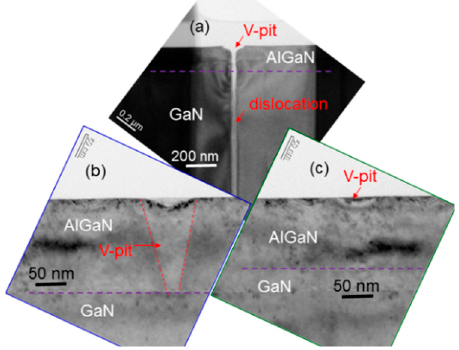
Figure 6. ( a ): TEM image of sample 8/8 showing the structure of a V-pit with a dislocation beneath. ( b ) and ( c ): TEM images of sample 8/8 showing the structures of a deep and a shallow V-pits, respectively, without dislocation beneath.